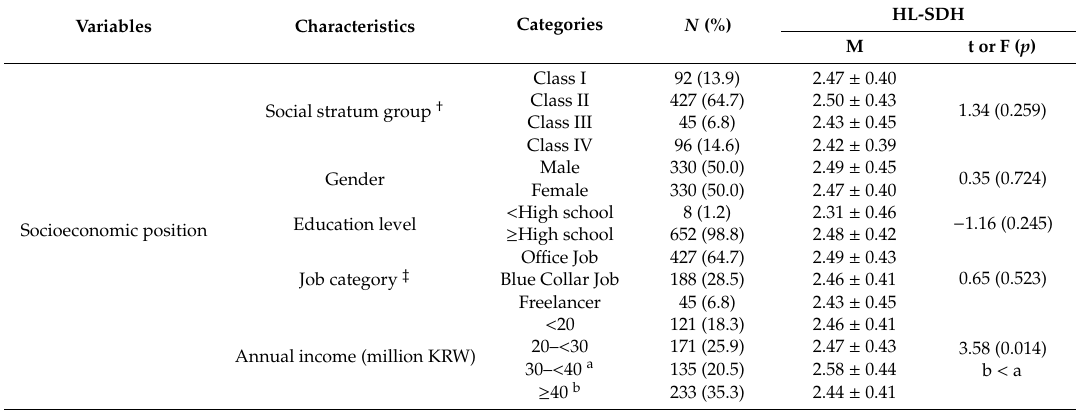
Table 3. HL-SDH by socioeconomic position and work environment among workers. ( N =